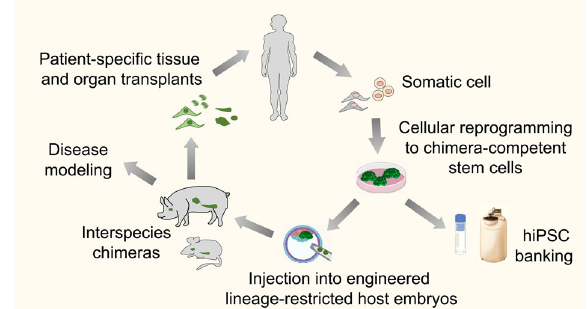
Fig. 3 Interspecies chimera technology for producing patient- speci fi c adult-staged tissues. Schematic of hiPSC-derived organo- genesis via interspecies chimerism. Reversion of primed, conven- tional hPSCs into chimera-competent primitive epiblast-like or totipotent-like stem cell states may facilitate engraftment in pre- implantation staged animal embryos. Injection into genetically altered animal embryos using blastocyst complementation technol- ogies may facilitate the generation of lineage-restricted human tissues or whole organs or for use in clinical